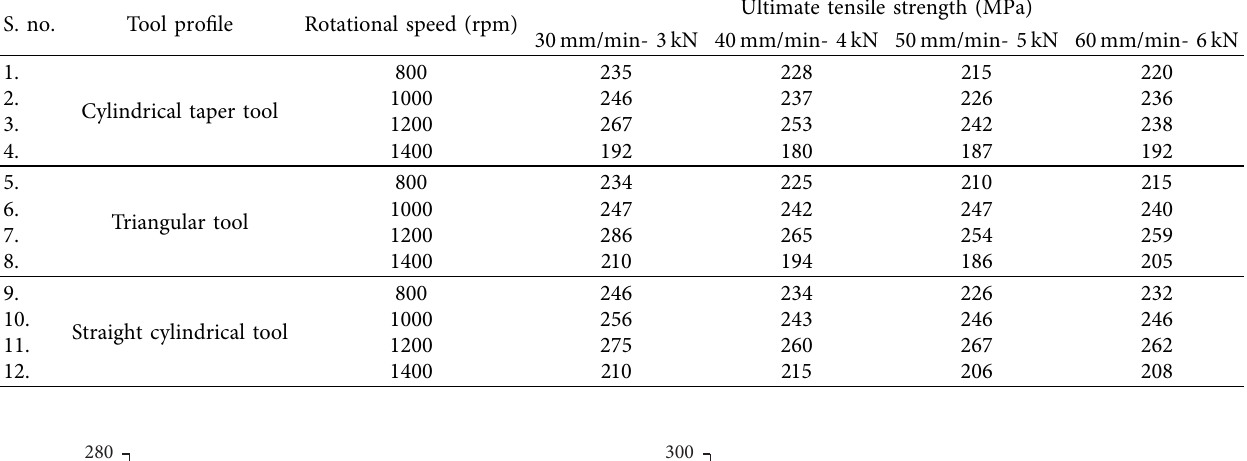
Table 5: Summary of the different tool profiles with ultimate tensile strength.